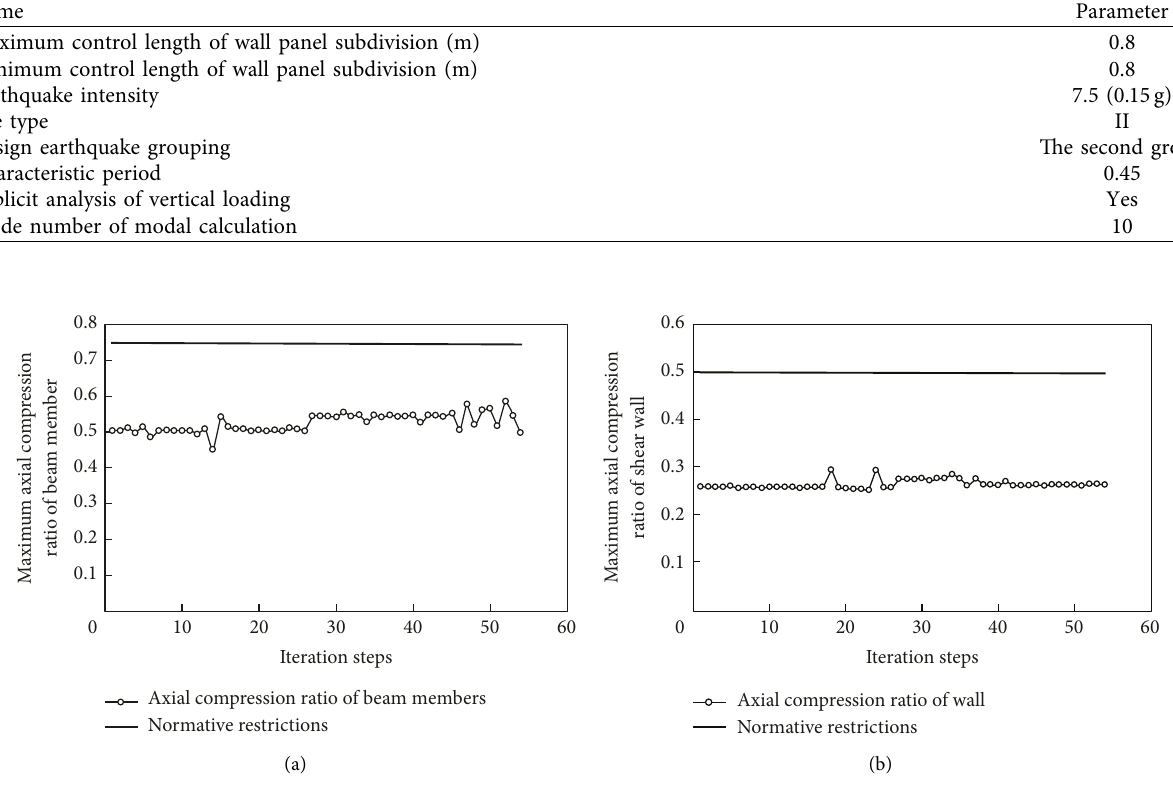
Figure 5: Comparison results of the maximum axial compression ratio of beam members and shear walls. (a) Axial compression ratio of the beam member. (b) Axial compression ratio of shear